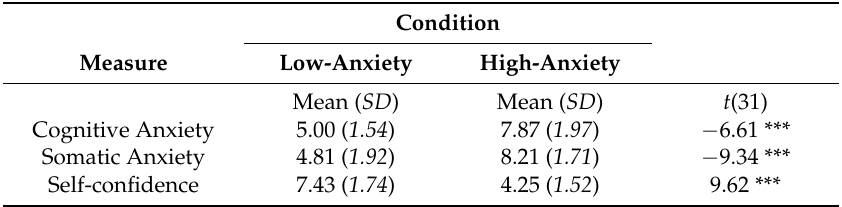
Table 1. Descriptive statistics of the Mental Readiness